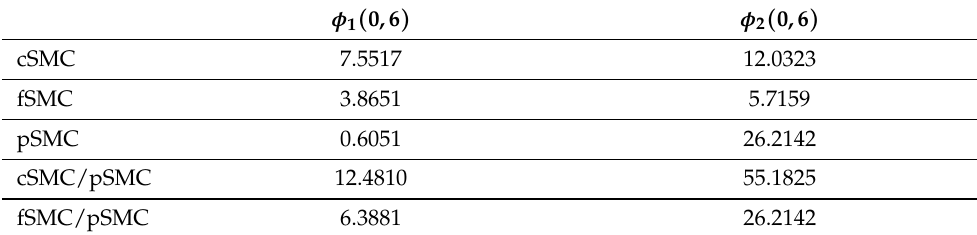
Figure 11. The trajectories of state variables q 1 and q 2 when ρ b = 0.6: cSMC (Blue solid line), fSMC (Yellow solid line) and pSMC (Red solid line). Table 4. MJVs of cSMC, fSMC and